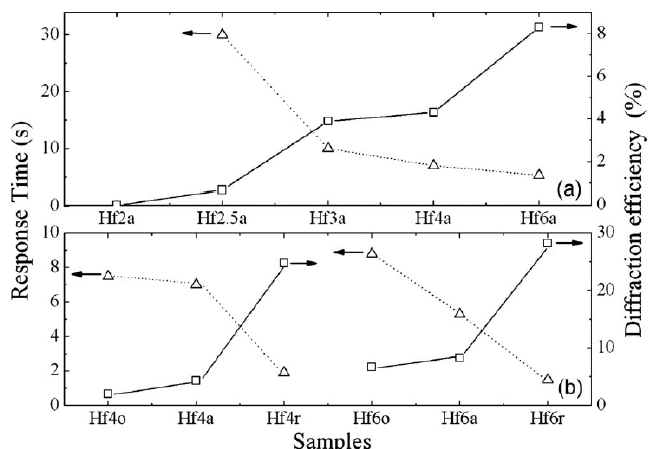
Figure 3. The Ultraviolet Photorefraction of LN:Hf Crystals at 351 nm. The samples are named after their Hf concentration in mol% and their as-grown (a), oxidized (o), or reduced (r) state